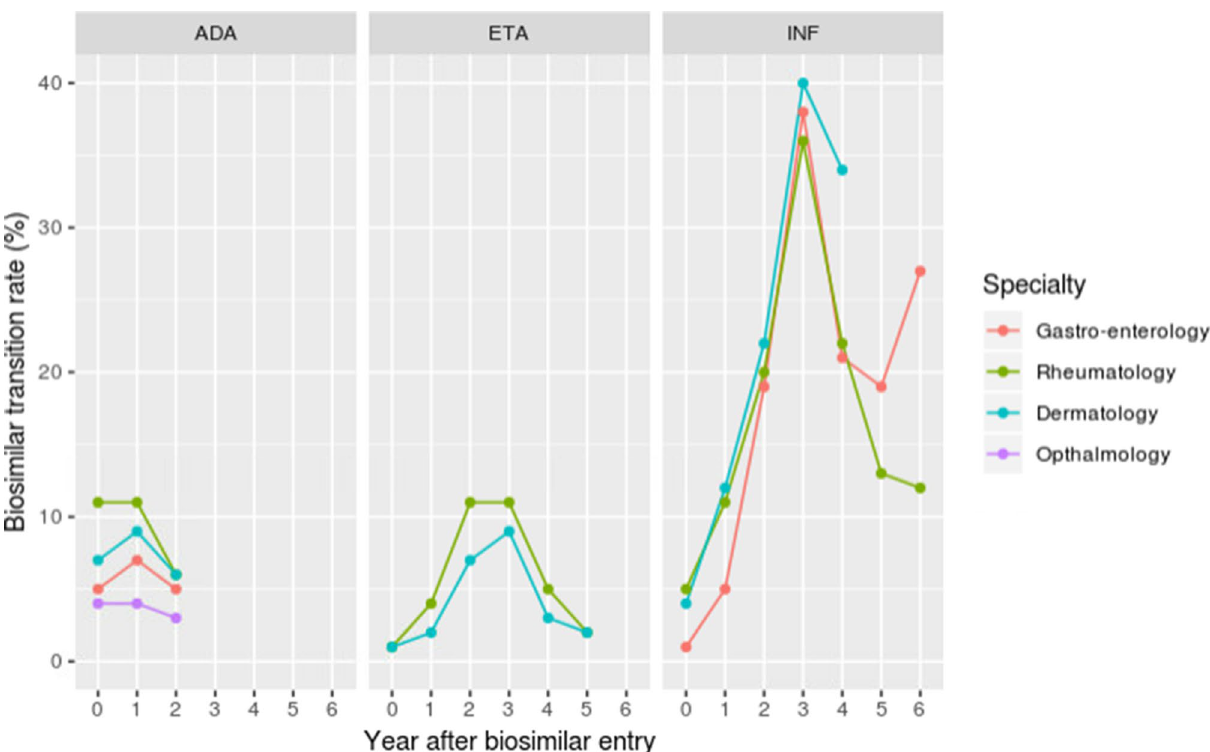
Figure 5. TNF-alpha inhibitors’ biosimilar transition rate by specialty between year 0 and 6 (if applicable) after first biosimilar entry for each molecule. ADA, ETA and INF refer to adalimumab, etanercept and infliximab